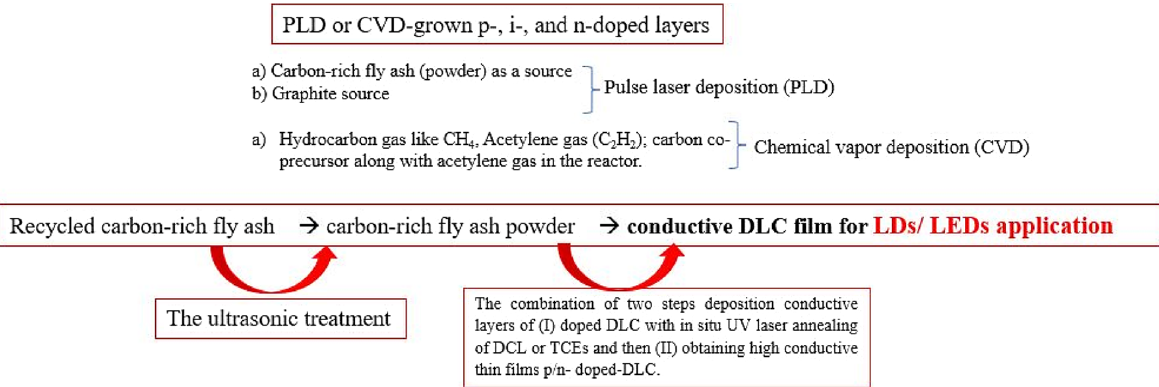
Fig. 4 Method of growing a transparent and conductive DLC thin film which can be employed as an alternative to the conventional TCO with comparable performance to recycled carbon as a waste material